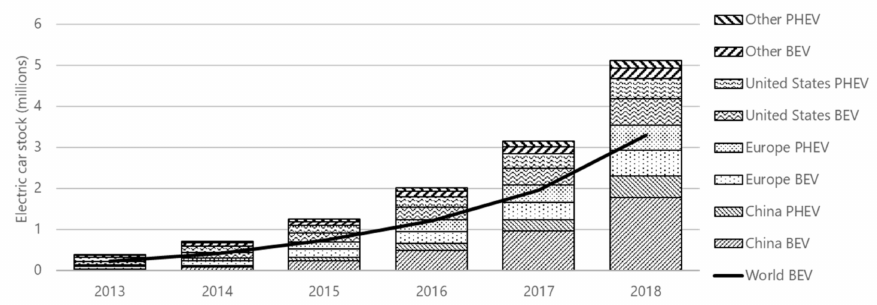
Figure 1. Global electric car sales and market share from 2013 to 2018 (BEVs = battery electric vehicles; PHEVs = plug-in hybrid electric vehicles)